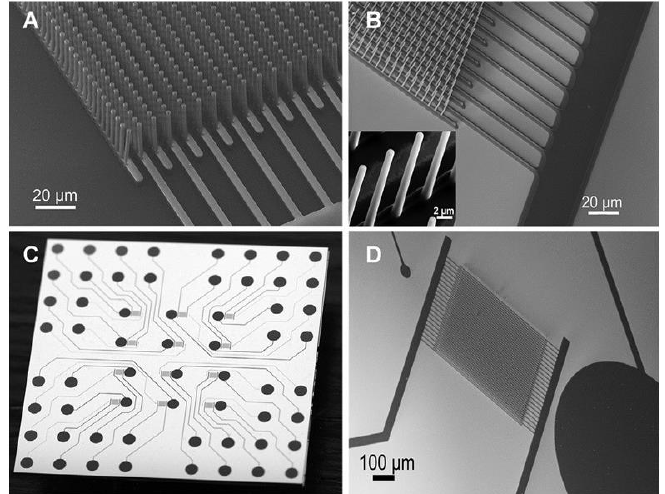
Figure 5. SEM images of 3D IDEAs with carbon pillars (diameter of 1.4 µm, height of 11 µm) inter- connected by interdigitated structures: ( A ) before pyrolysis; and ( B ) after pyrolysis. ( C ) Photograph of a silicon chip with the pyrolyzed carbon electrode array structures (12 three-electrode systems at the center with surrounding contact pads). ( D ) SEM image of a three-electrode system. Reprinted from [129], Copyright © 2022 Elsevier Ltd. All rights reserved.